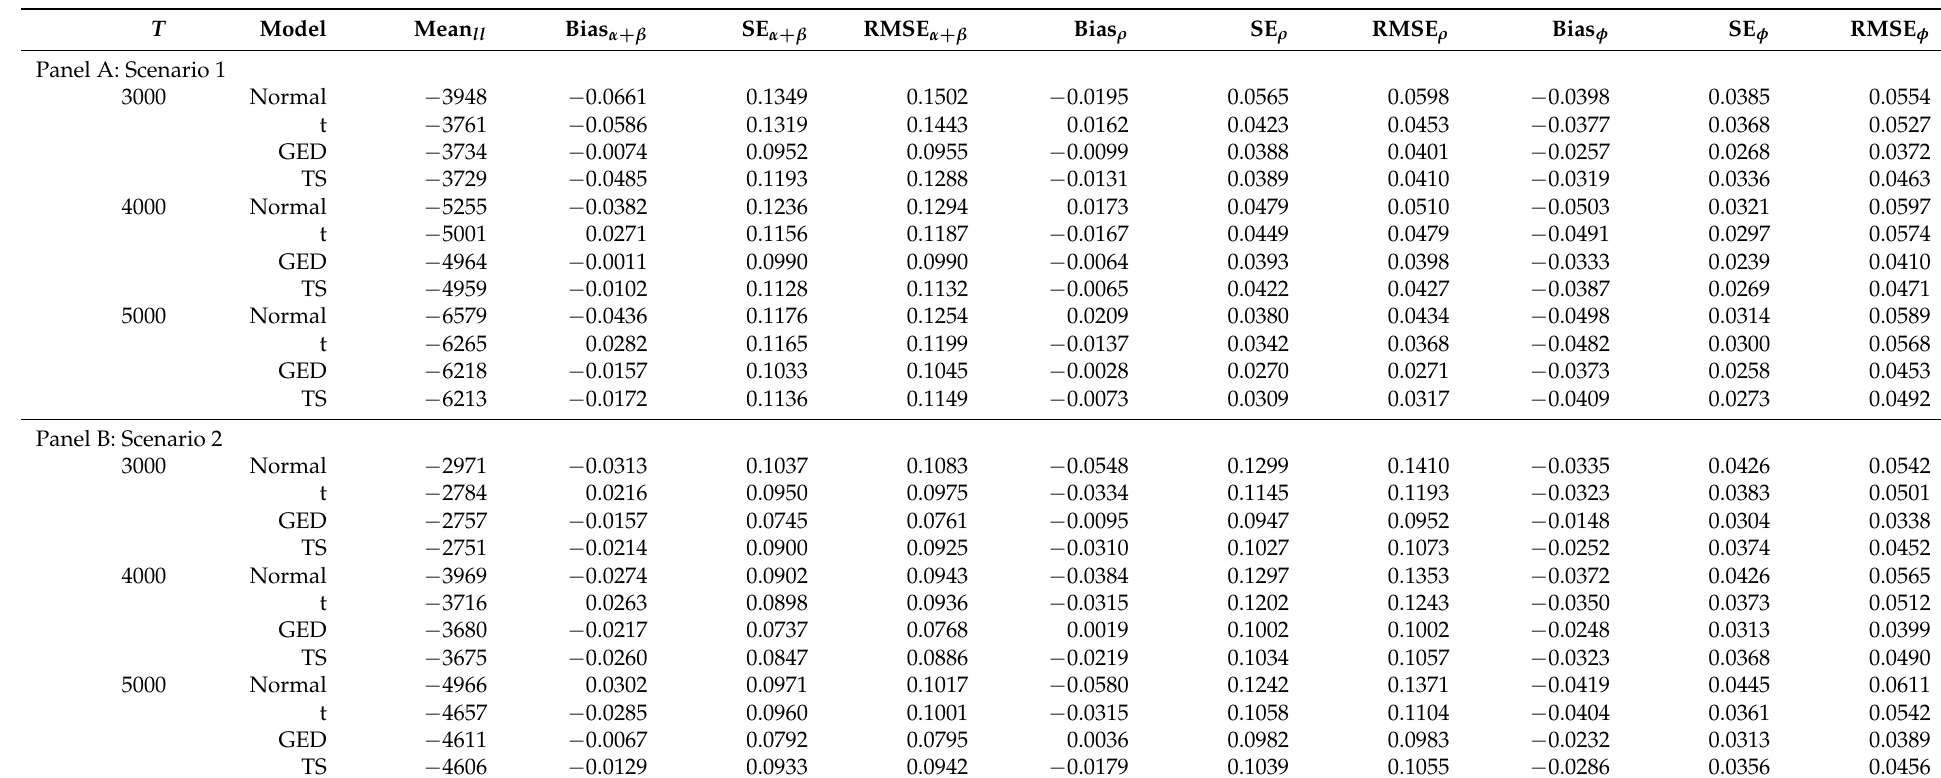
Table 2. Simulation results: